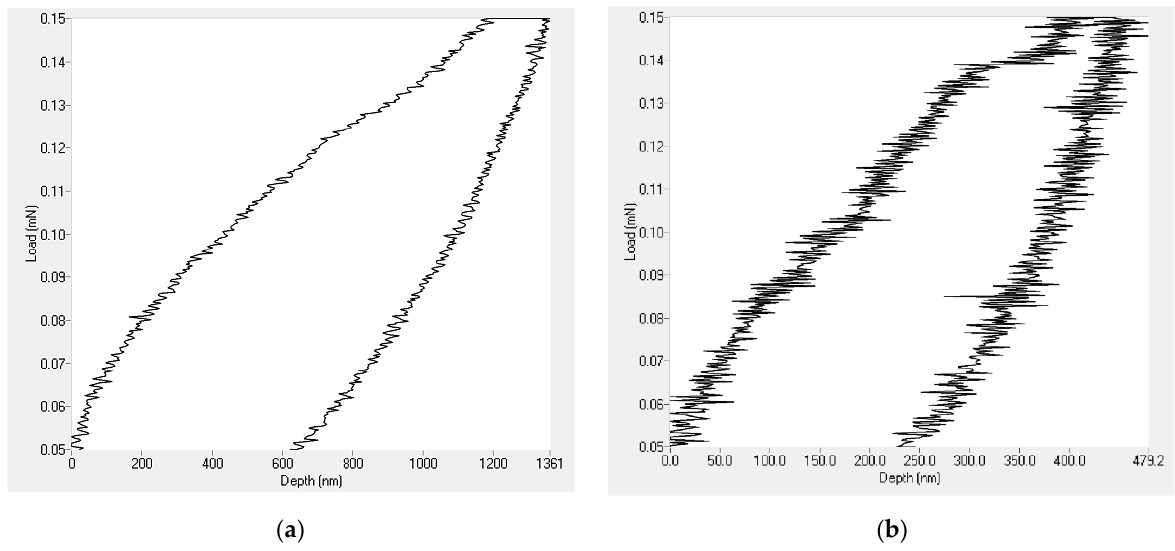
Figure 9. Nanoindentation loading and unloading curve for ( a ) PVDF only coating and ( b ) PVDF composites containing 1.5 g Al 2 O 3 .